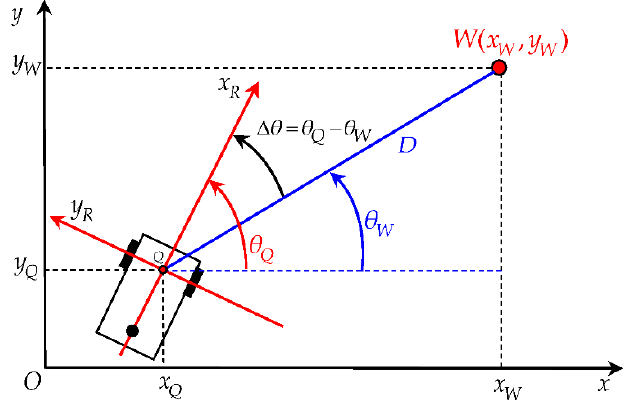
Figure 2. The parameters of the robot and the next waypoint.